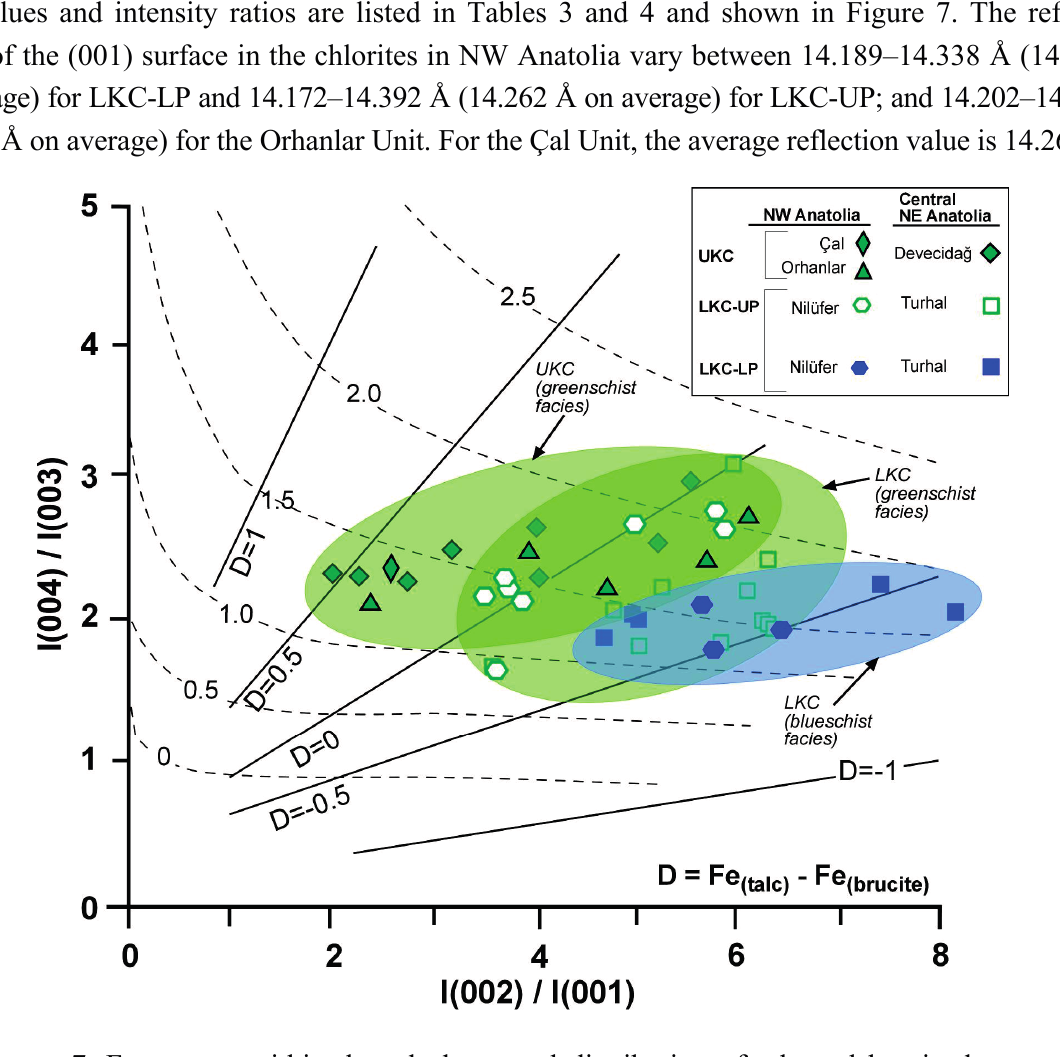
Figure 7. Fe content within the talc layer and distribution of talc and brucite layers of chlorite minerals according to basal peak ratios [44] in the Karakaya Complex